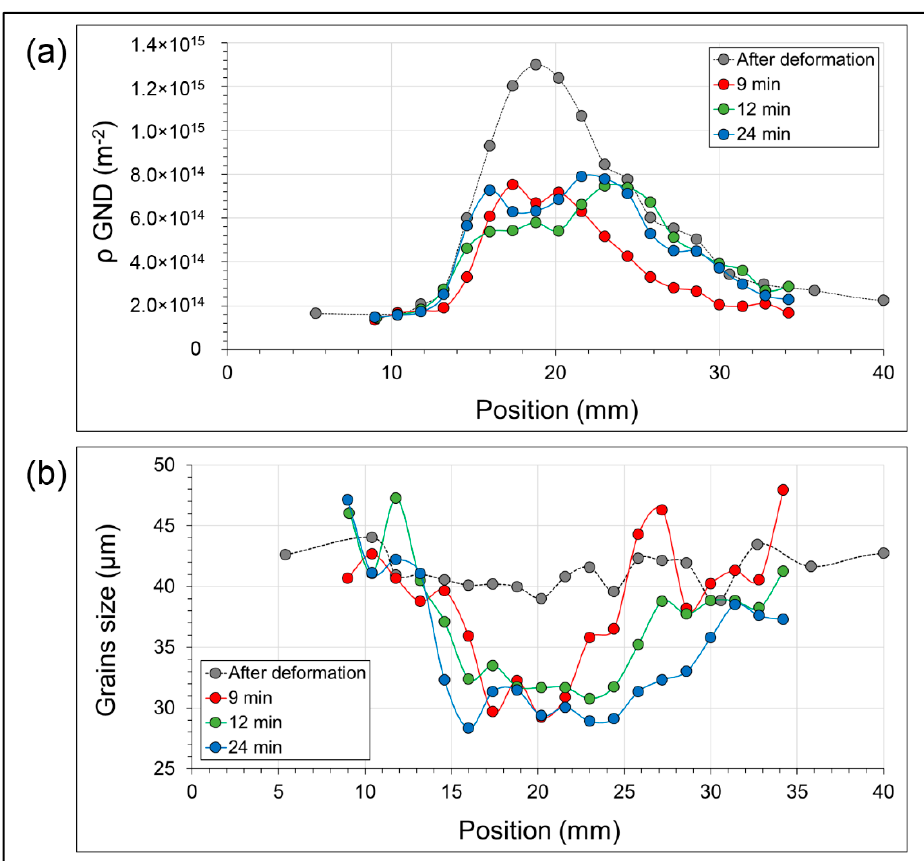
Figure 19. Influence of a 1100 °C heat treatment on the ( a ) GND density values and ( b ) grain sizes of trapezoidal samples. Specific recrystallization holding times were selected from each L-PBF condition: L-PBF-1 t rec = 9 min; L-PBF-2 t rec = 12 min; L-PBF-3 t rec = 24 min.